Question: How would you classify this visualization?
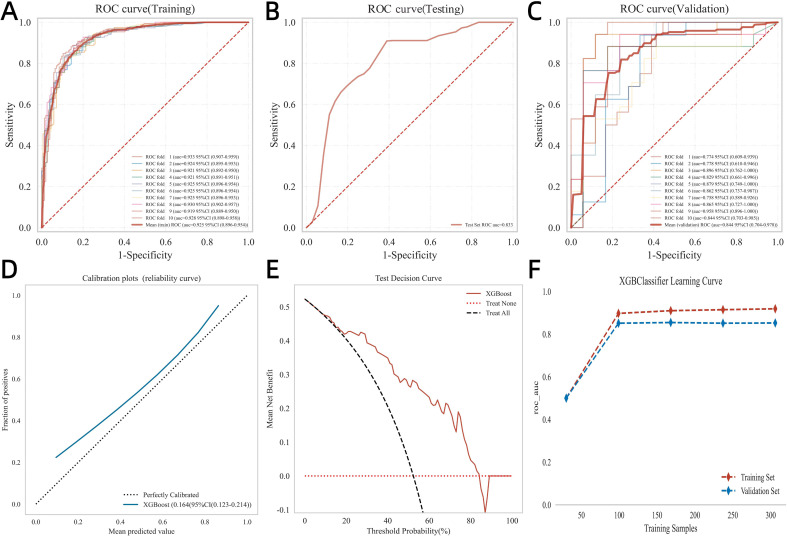
Answer: line